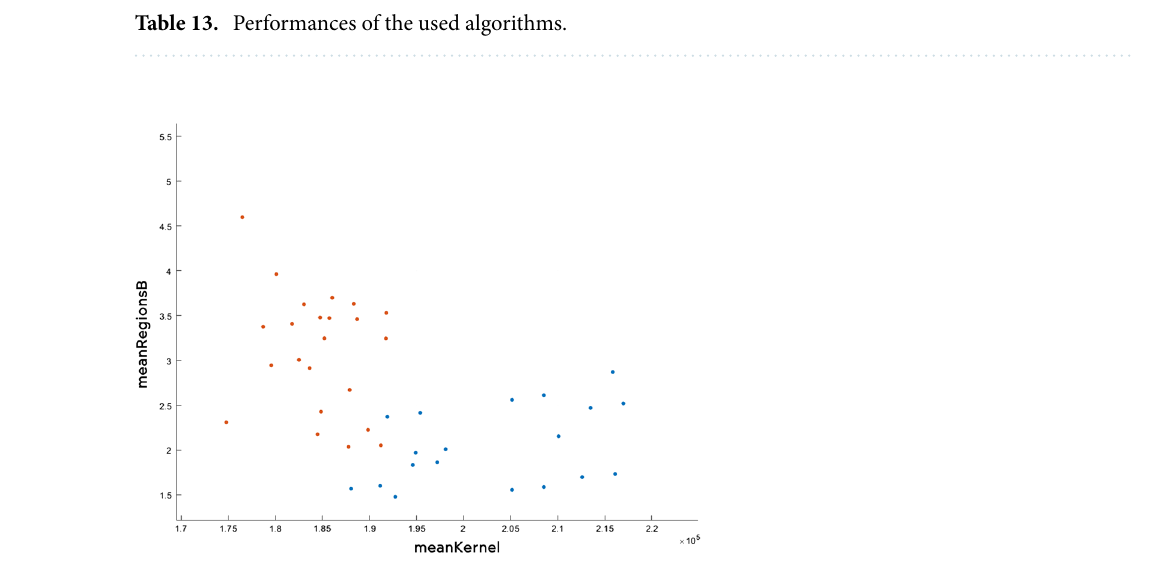
Figure 22. Correctly analysed data.